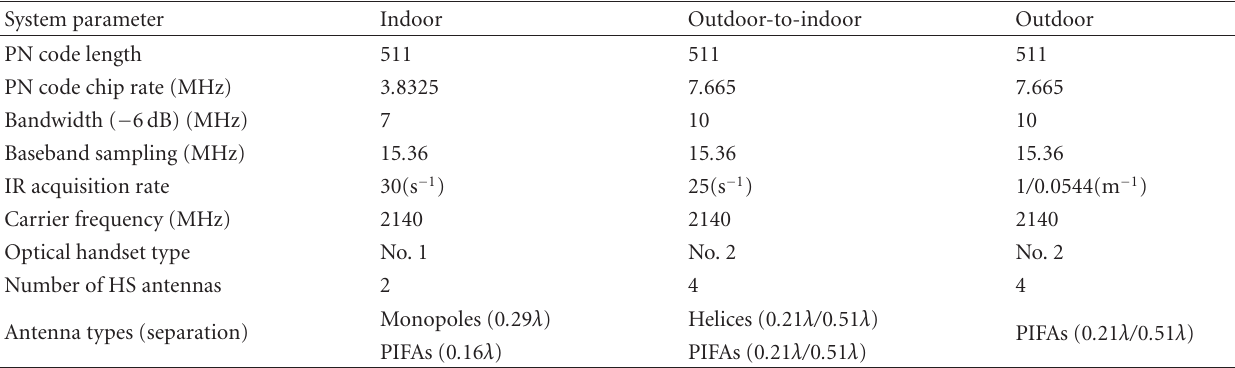
Table 1: Main parameters of channel sounding equipment used in the di ff erent campaigns. System